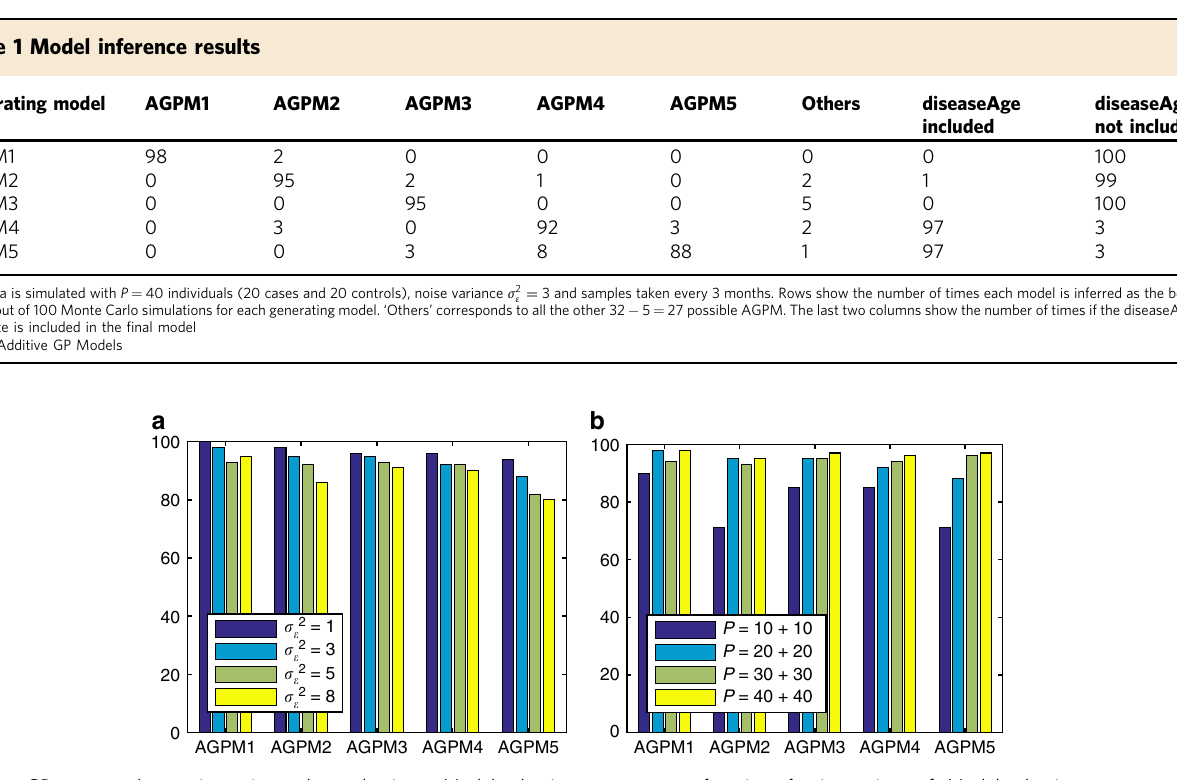
Fig. 2 LonGP accuracy by varying noise and sample size. a Model selection accuracy as a function of noise variance. b Model selection accuracy as a function of sample size. AGPM stands for Additive GP Models. y -axis shows the number of times the correct model is inferred as the best model out of 100 Monte Carlo simulations (Simulated data